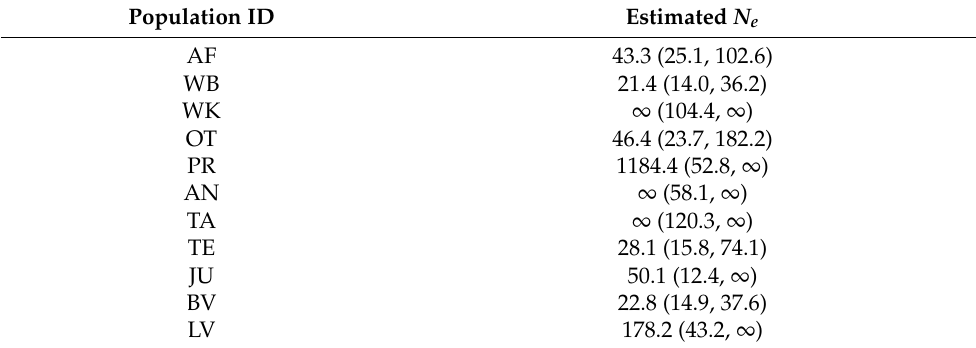
Table 2. Effective population size ( N e ) estimates and 95% confidence intervals for wild O. niloticus population samples 1 collected in Ghana. ∞ = infinite. AF = Afram, WB = White Volta–Binaba, WK = White Volta–Kulugu, OT = Oti, AN = Ankobra, TA = Tano–Asuhyea, TE = Tano–Elubo, JU = Juen, BV = Black Volta, and LV = Lower Volta.